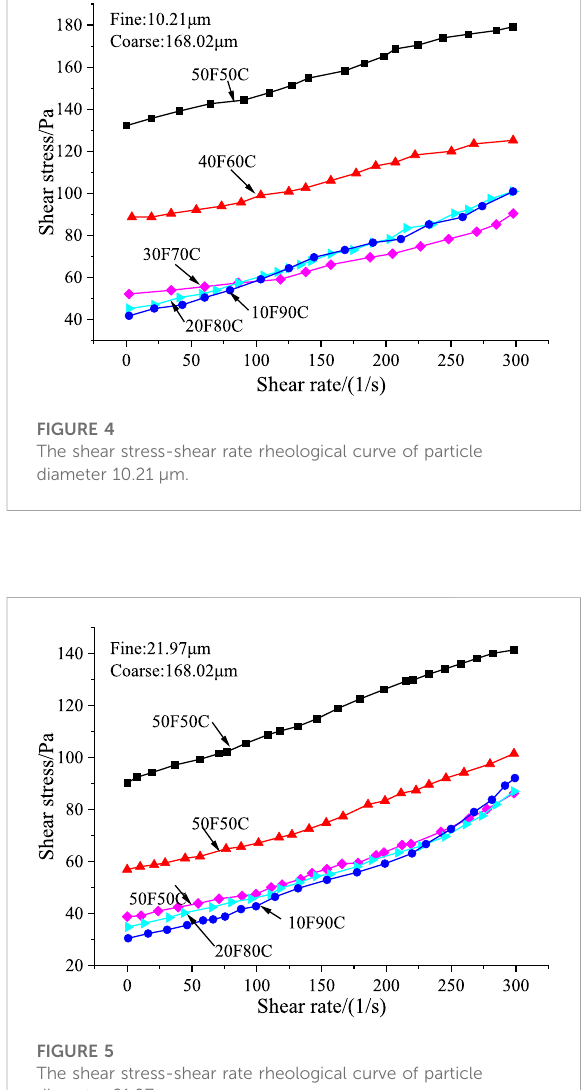
FIGURE 5 The shear stress-shear rate rheological curve of particle diameter 21.97 μ m.